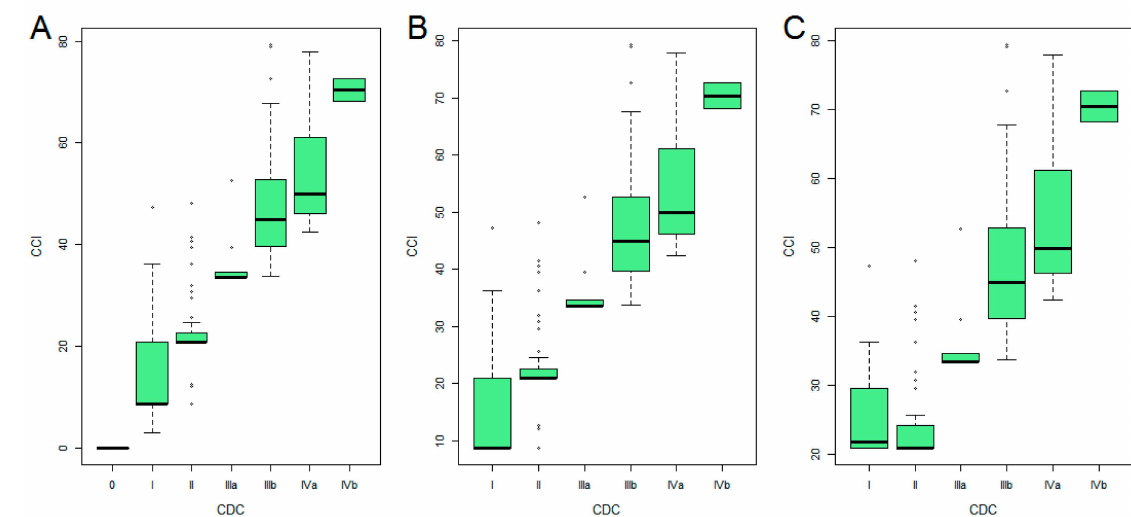
Figure 1. Distribution of CCI and CDC in the overall series ( A ), the subgroup of complicated patients ( B ) and the subgroup of patients with more than one complication ( C